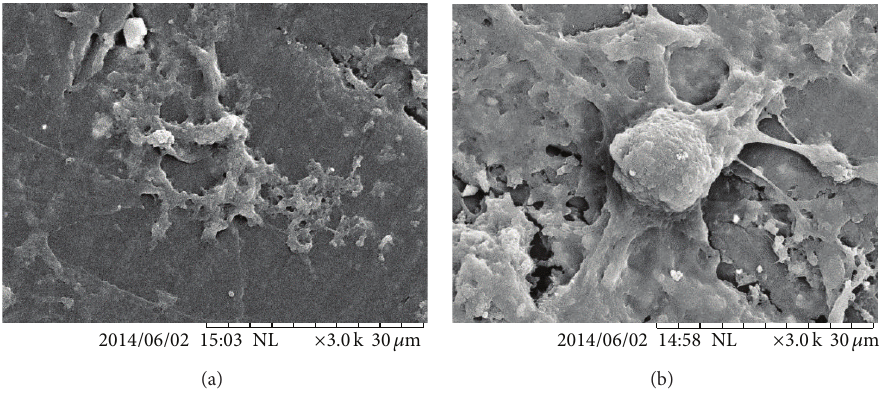
Figure 2: SEM image of the morphology of the attached cell on the (a) bare PEEK, (b) treated layer.